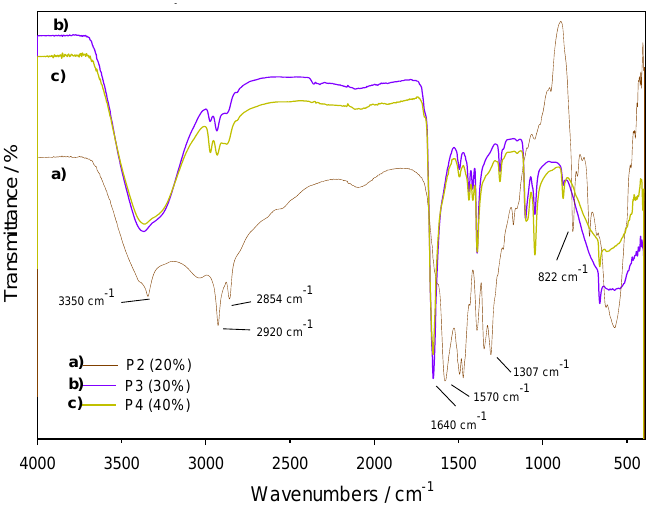
Figure 16. IR spectra of P2 (20%), P3 (30%) and P4 (40%).